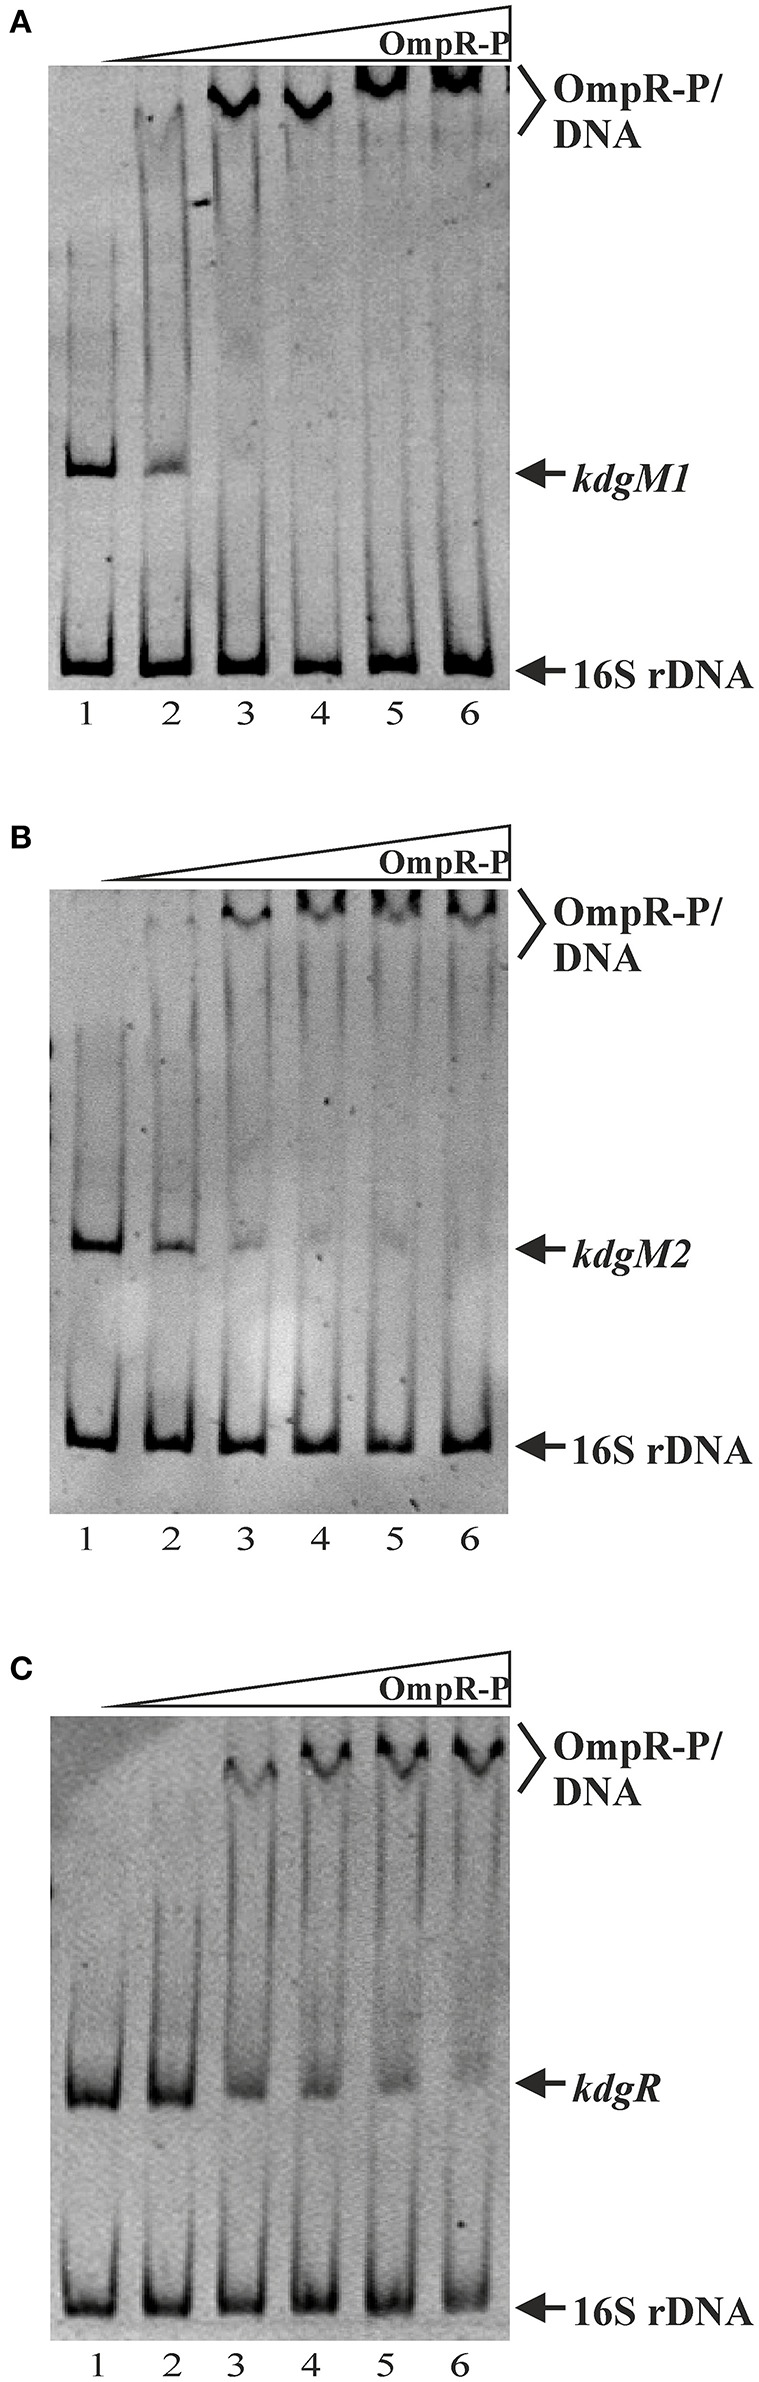
Binding of phosphorylated OmpR to the kdgM1, kdgM2-pelP-sghX, and kdgR regulatory regions examined using EMSAs. A range of concentrations of OmpR-P were incubated with DNA fragments representing the kdgM1 (A, 544 bp), kdgM2-pelP-sghX (B, 500 bp) and kdgR (C, 441 bp) promoters which contain putative OmpR-binding sites. A fragment of 16S rDNA (304 bp) was included in each reaction mixture as a non-specific binding control. The DNA fragments were mixed with increasing concentrations of OmpR-P in lanes 1–6: 0, 0.167, 0.333, 0.500, 0.583, 0.667 μM. The identities of the bands resolved by electrophoresis on native 5% polyacrylamide gels are indicated.